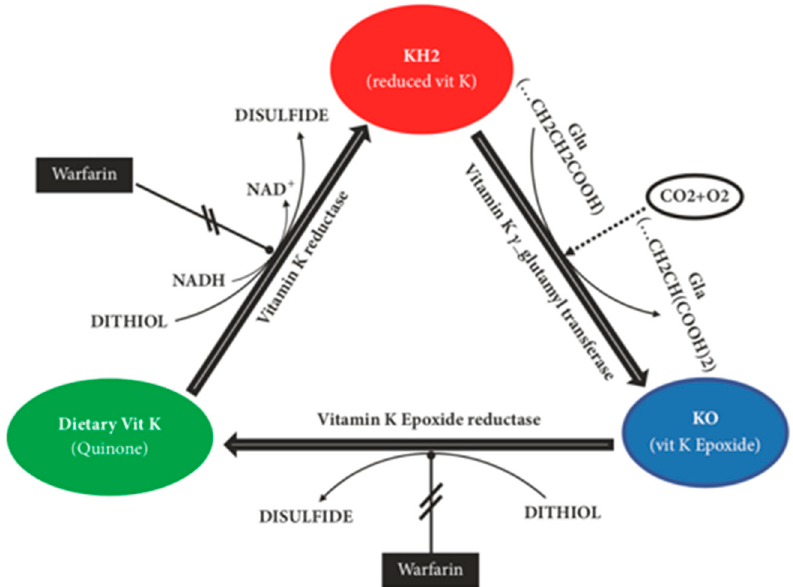
Figure 2. The vitamin K cycle. The initial step in the cycle is for the enzyme vitamin K reductase to convert the dietary vitamin K into reduced vitamin K (KH 2 ). The enzyme vitamin K γ -glutamyl transferase then converts this into vitamin K epoxide (KO), which activates the compound. Finally, this is reduced back into the dietary form of vitamin K by the enzyme vitamin E epoxide reductase. Warfarin can halt the actions of this enzyme as well as the vitamin K reductase, enabling prolongation of the International Normalised Ratio (INR) [3].